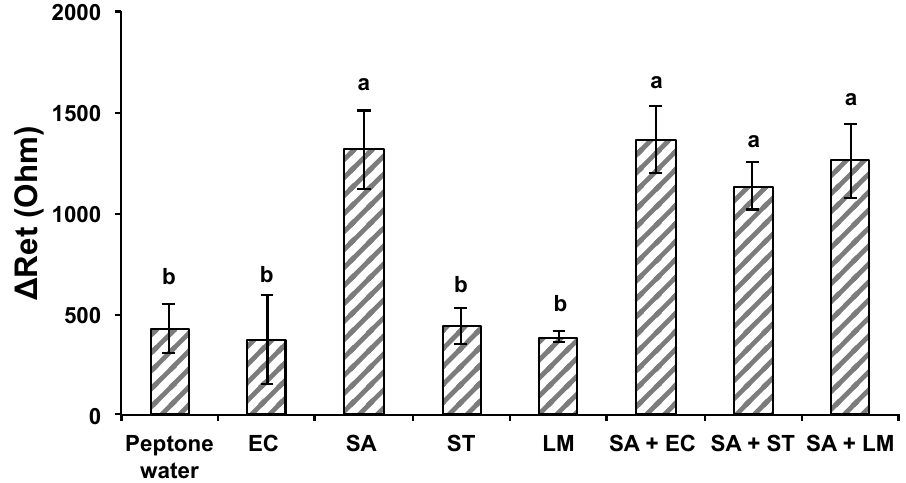
Figure 10. Specificity and selectivity of the S. aureus MEI sensor against nontarget bacteria and cocktail samples. Bacteria suspensions in pure and mixed samples. EC: E. coli K12, SA: S. aureus , ST: S. typhimurium , LM: L. monocytogenes , SA + EC: a mixture of S. aureus and E. coli K12, SA + ST: a mixture of S. aureus and S. typhimurium , and SA + LM: a mixture of S. aureus and L. monocytogenes . Error bars indicate the standard deviation of the mean. Different letters (a and b) in the figure indicate significant differences ( p ≤ 0.05).